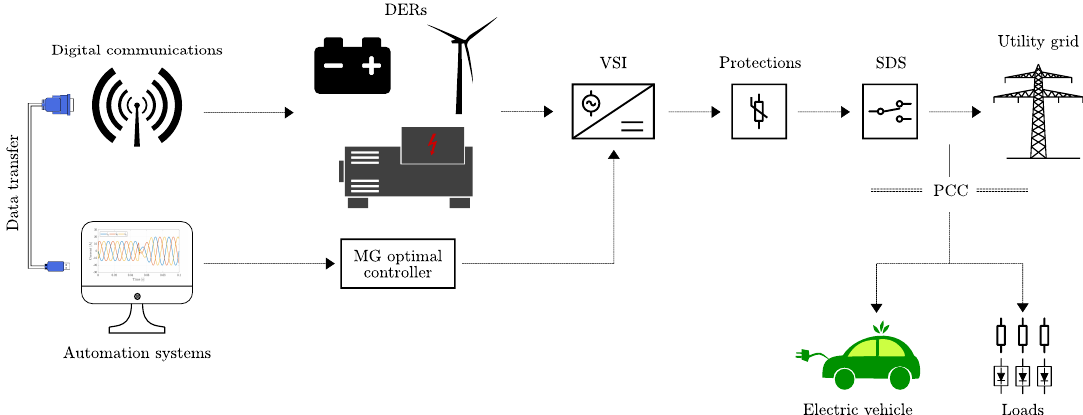
Figure 1. Basic operative elements composing a Microgrid (MG). A network of different power sources is distributed, administrated, and controlled at the same station to provide stable energy to any connected